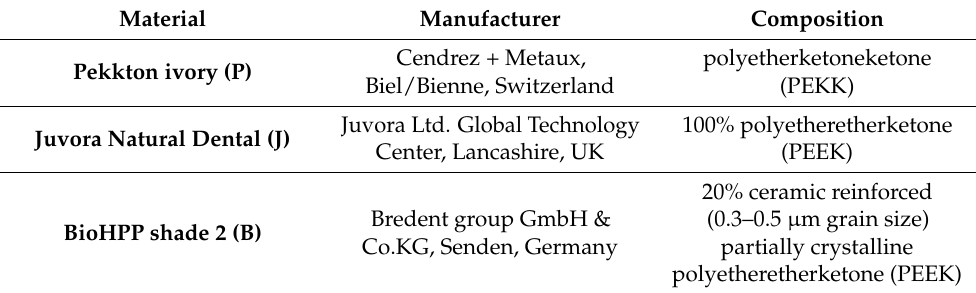
Table 1. The PAEK materials selected for study ( n =